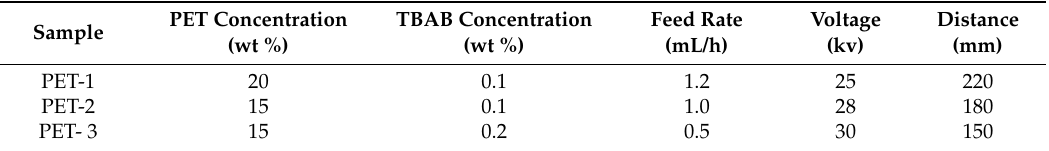
Table 1. Electrospinning process parameters for obtaining poly(ethylene terephthalate) (PET) nanofibers.